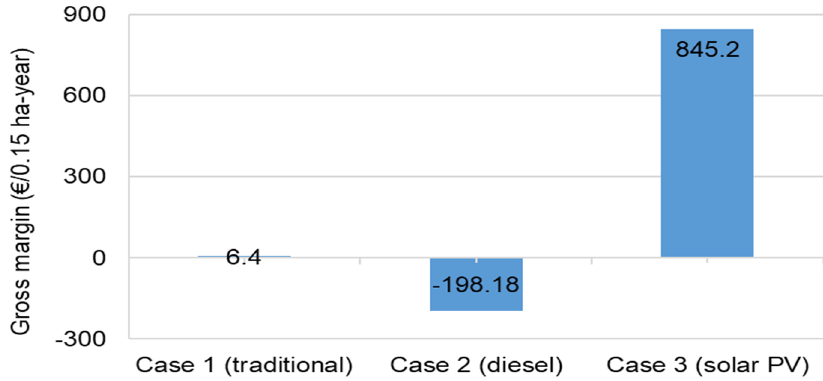
Figure 4. Gross margin for a reference farmer in a year (from 0.15 ha land).